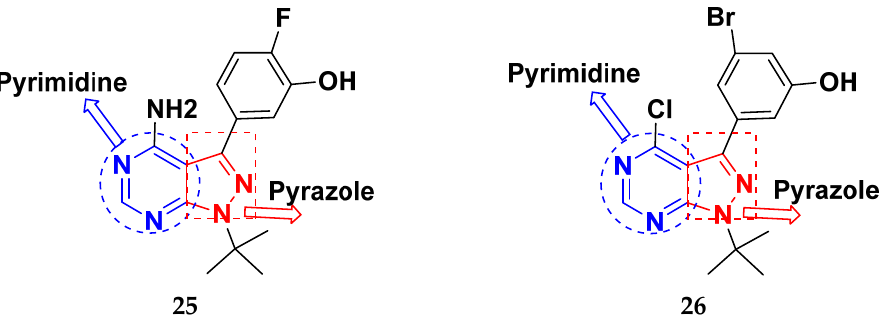
Figure 29. Pyrimidine ‐ pyrazole based hybrid ( 25 and 26 ). Liang et al. (2013) synthesized and patented pyrimidine-pyrazole based hybrid molecules, and evaluated their anticancer activity as mammalian target of rapamycin mTOR inhibitors. Compound 27 (Figure 30) showed potent activity on A549 and U-87MG (glioma cells) with an IC 50 < 1 µ M [77].